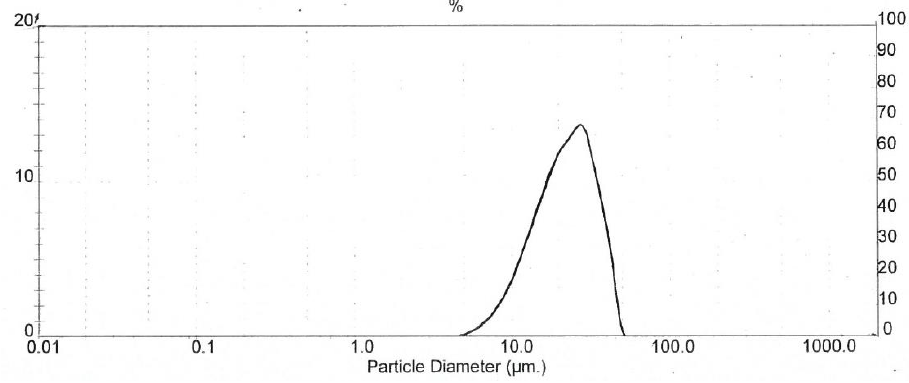
Figure 5. Particle size distribution of CCK-R7.